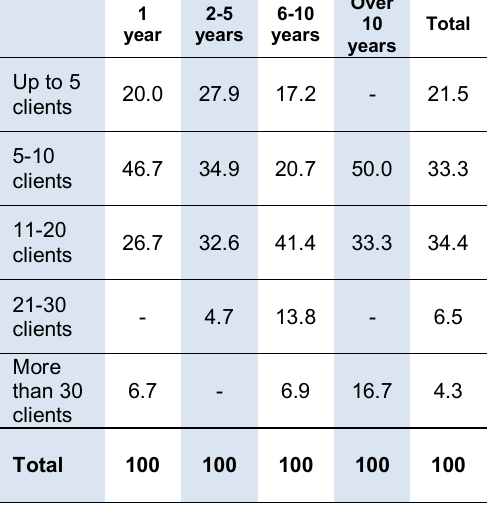
Table 6 - number of clients per years since